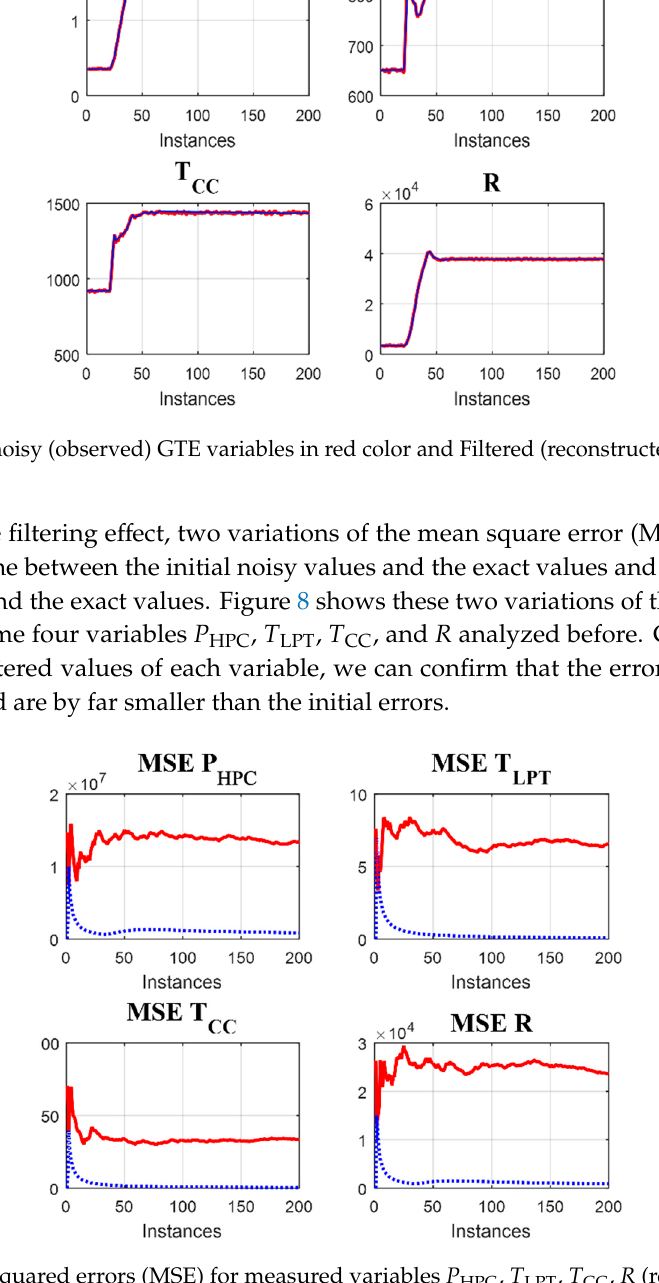
Figure 8. Mean squared errors (MSE) for measured variables P HPC , T LPT , T CC , R (red line) and their estimations ˆ P HPC , ˆ T LPT , ˆ T CC , ˆ R (blue dotted line).